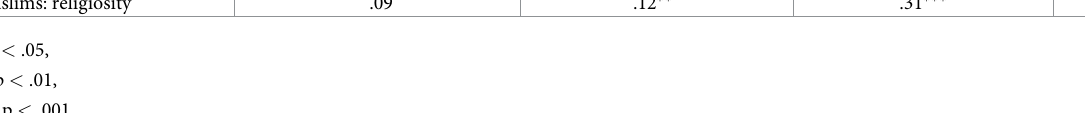
Table 3. Correlations between religiosity and extremism attitude scales (standardised correlations shown; estimator MLR). Right-wing extremism Left-wing extremism Islamist extremism N students/N classes -.02